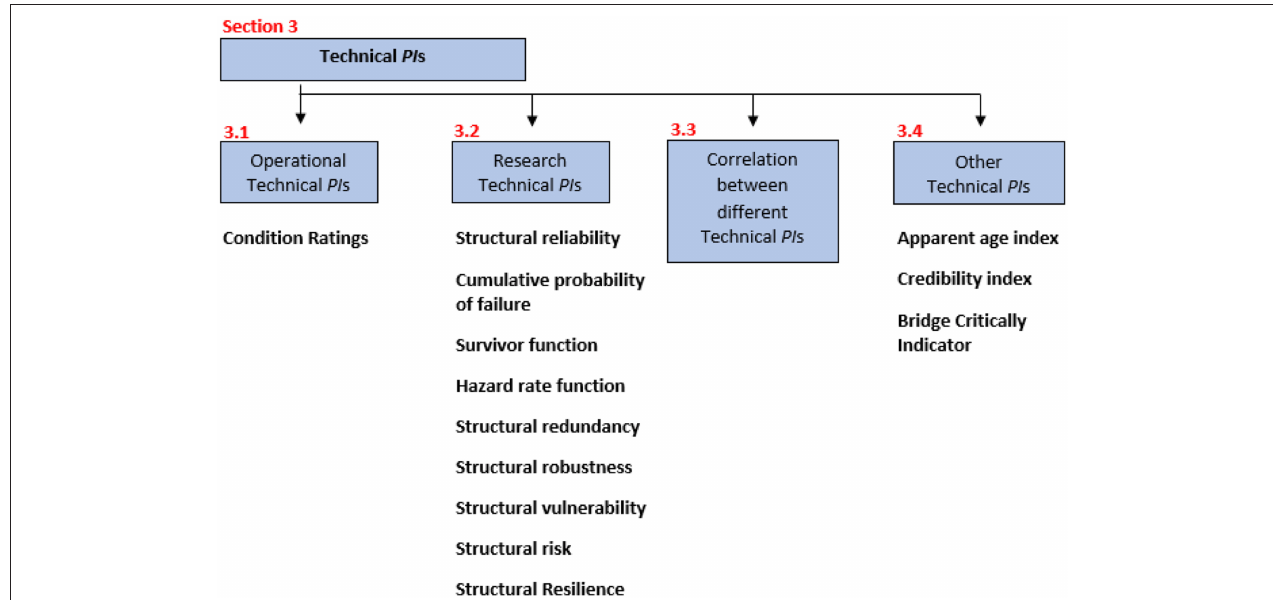
FIGURE 3 | Sketch of the investigated technical PI